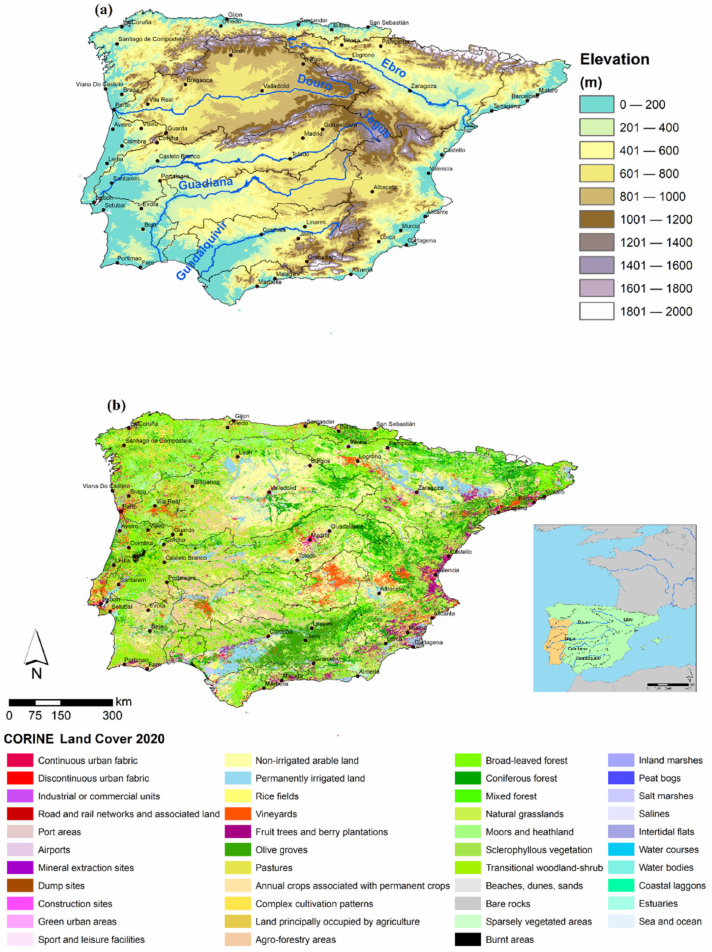
Figure 1. Iberian Peninsula; ( a ) elevation (in m) and ( b ) CORINE land cover for the year